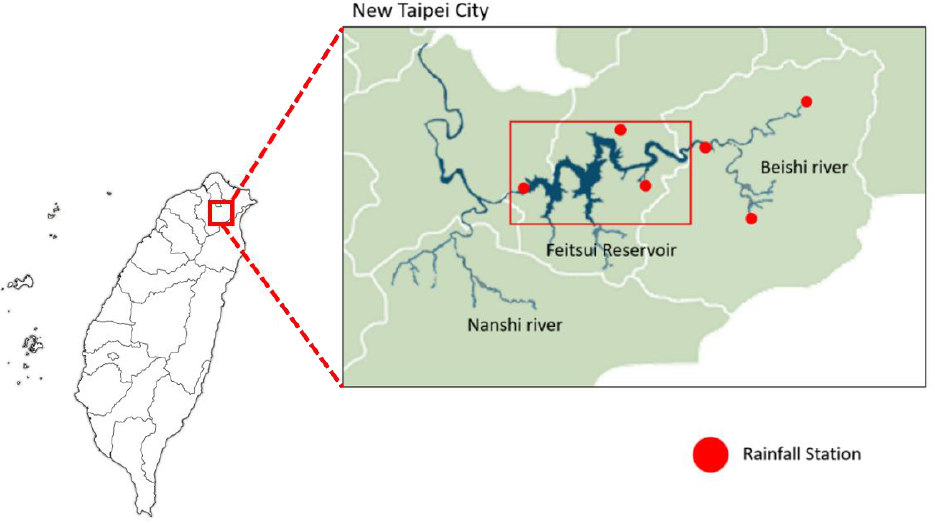
Figure 1. Location map of the Feitsui Reservoir. Table 1. Variable description of the Feitsui Reservoir.